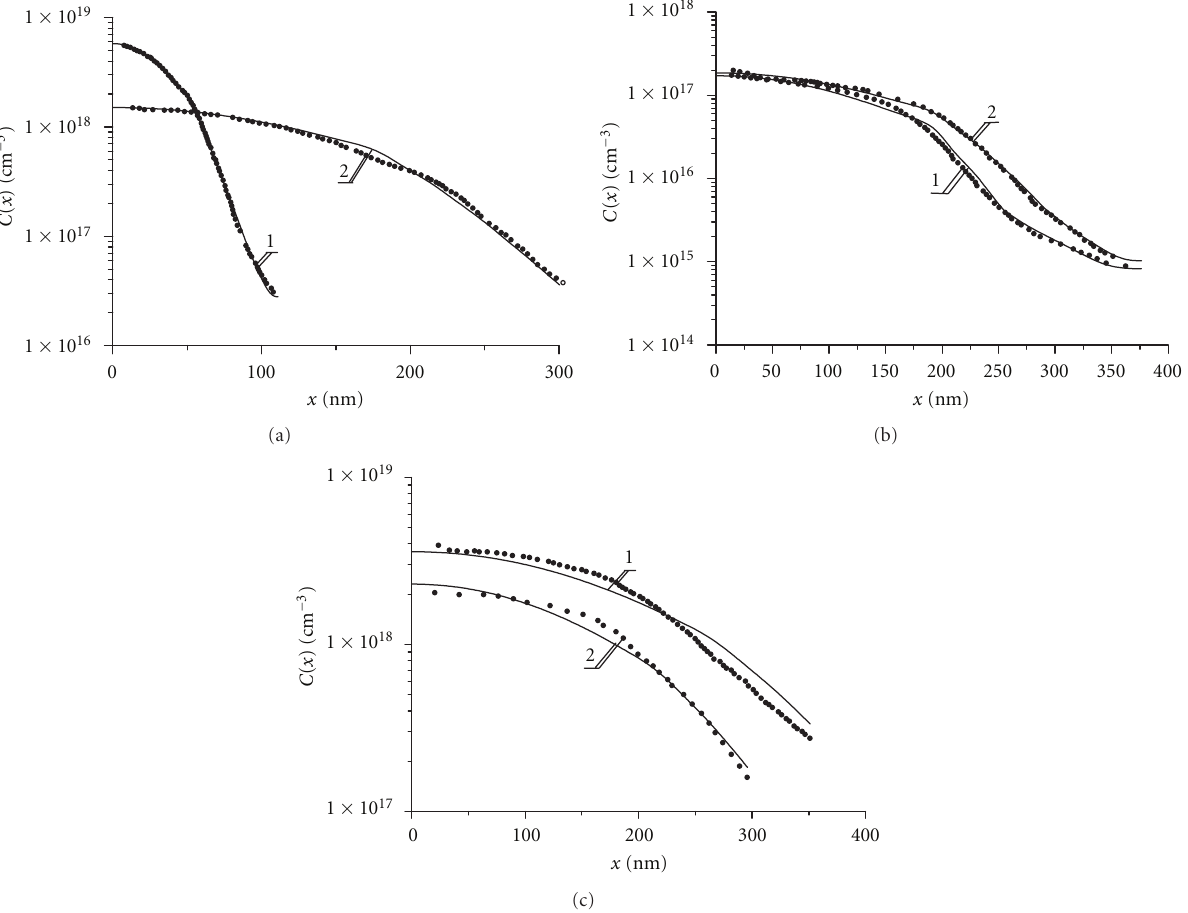
Figure 4: Distribution in non-porous SiC (curves 1) and porous SiC (curves 2) of: erbium after di ff usion at 1700 ◦ C for 120 min (a), vanadium after di ff usion at 2200 ◦ C for 120min (b), and erbium after di ff usion at 2200 ◦ C for 120min (c). Points show experimental data, solid curves show results of fitting.